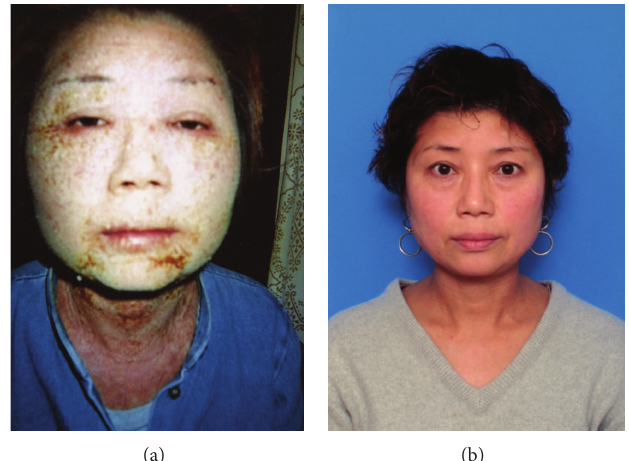
Figure 3: Clinical features of facial skin rash in case 2 (a 48-year-old female). (a) October, 2007 (severe rash), (b) June, 2014 (complete remission). After the patient happened to use shampoo and body soap equipped in a hotel, her face became markedly swollen by severe and itchy rash with secondary infection and scratch injury. Complete avoidance of the detergents and cleansing soap led to long-lasting complete remission without using steroid ointment. The patient allowed us to present her whole